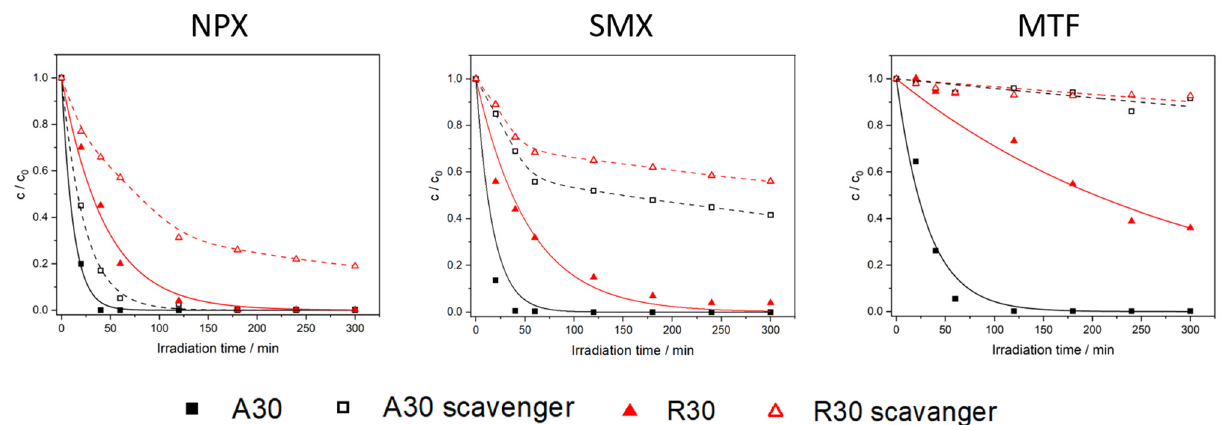
Figure 1. The effect of radical scavenger added on the kinetics of the photocatalytic degradation of naproxen (NPX), sulfamethoxazole (SMX) and metformin (MTF) in the presence of anatase (A30) and rutile (R30).